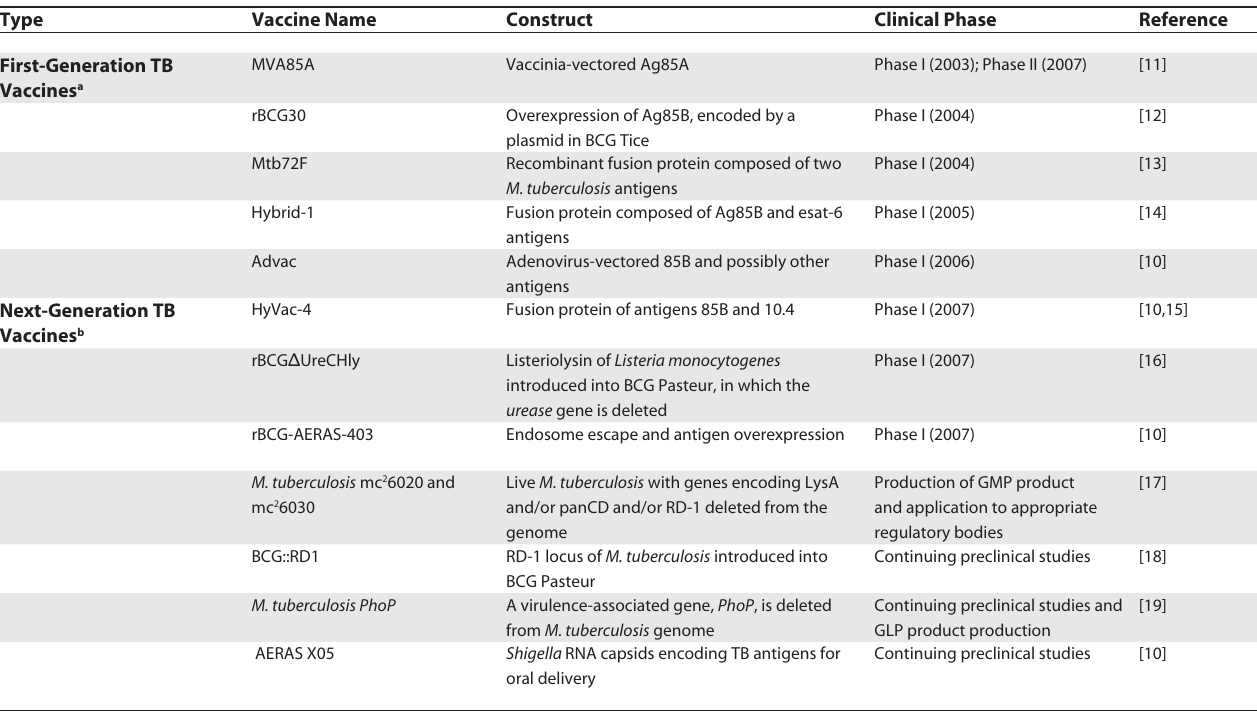
Table 1. Summary of TB Vaccines Currently Under